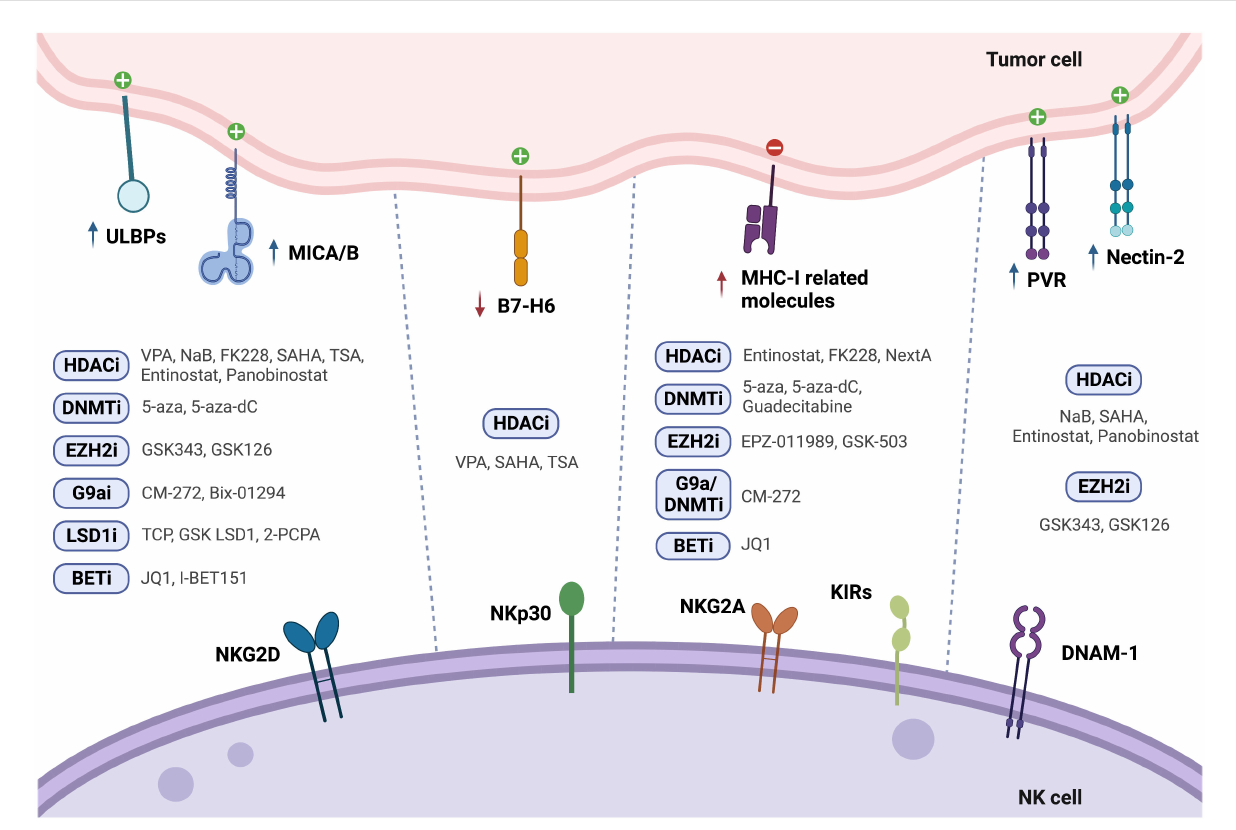
FIGURE 1 Modulation of NK cell ligands following tumor cell treatment with epigenetic drugs ( ↑ - upregulation; ↓ -